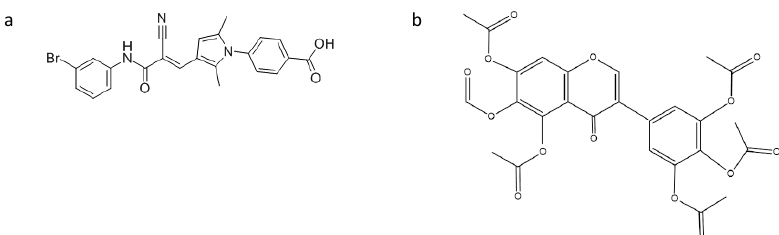
Figure 2. Structures of: ( a ) RNPA 1000; and ( b ) iriginol